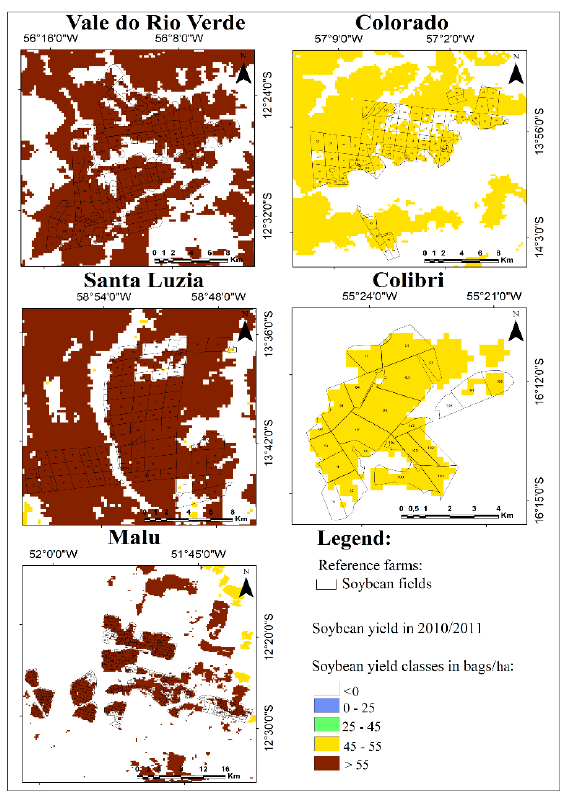
Figure 13. Spatial distribution of the soybean crop yield (60-kg bags per ha − 1 ) in the agglomerates Vale do Rio Verde, Colorado, Santa Luzia, Colibri, and Malu in the 2010/2011 crop season.